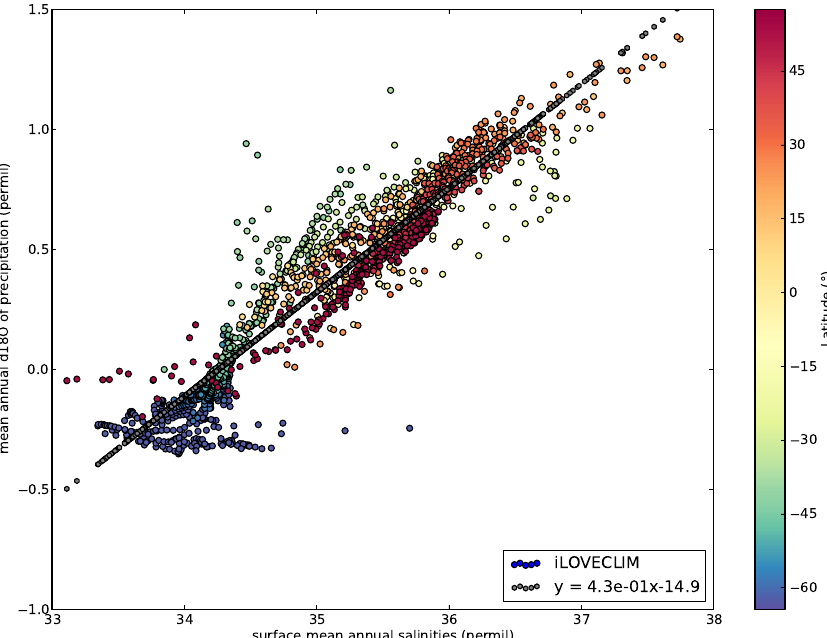
Fig. 5. Near surface ocean annual δ 18 O-Salinity relationship in i LOVECLIM for the Atlantic ocean. Linear fit to the model data is given in the equation in the bottom right box, with a R 2 coefficient of 0 . 877. Performing the same analysis on Atlantic ocean data from the GISS database, we obtain a linear regression of 0 . 52 ×− 17 . 9 with a R 2 of 0 . 81. The colour scale applied on modelled points is the given latitude of each